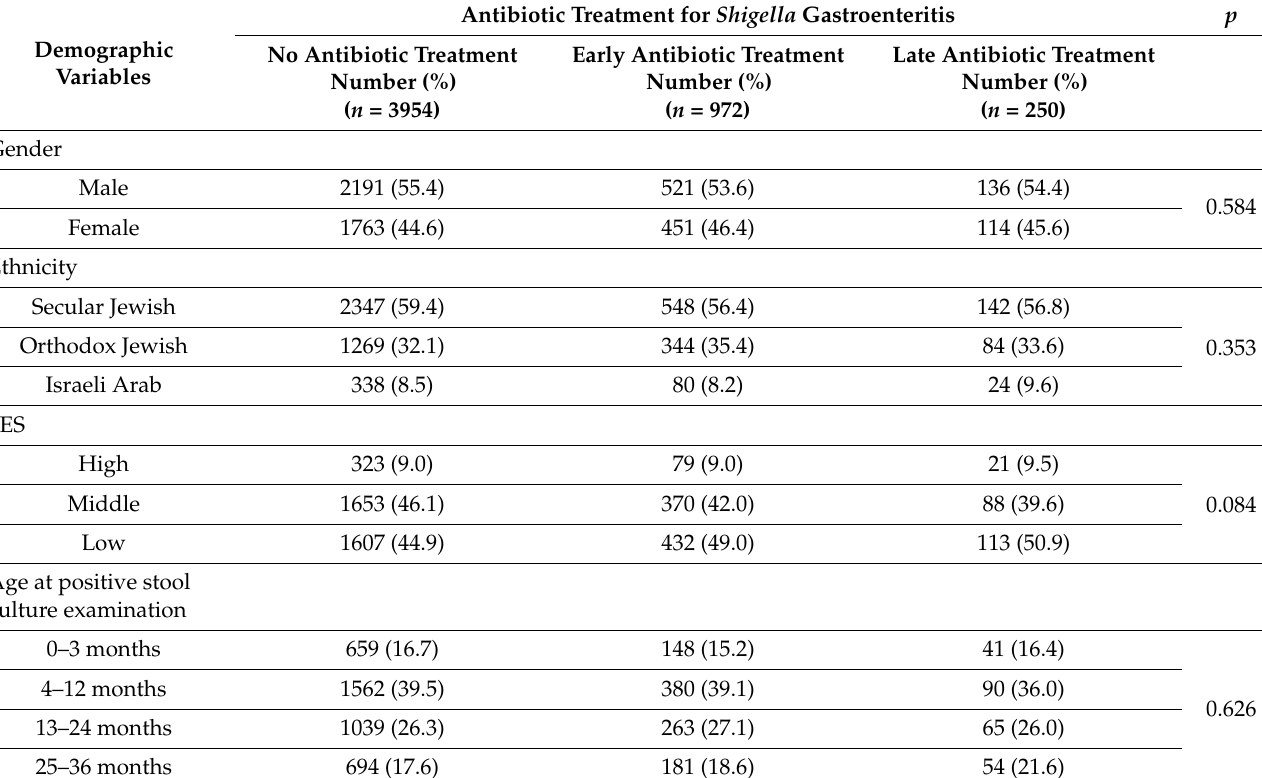
Table 1. Comparison of demographic variables between the study groups: no antibiotic treatment, early antibiotic treatment, and late antibiotic